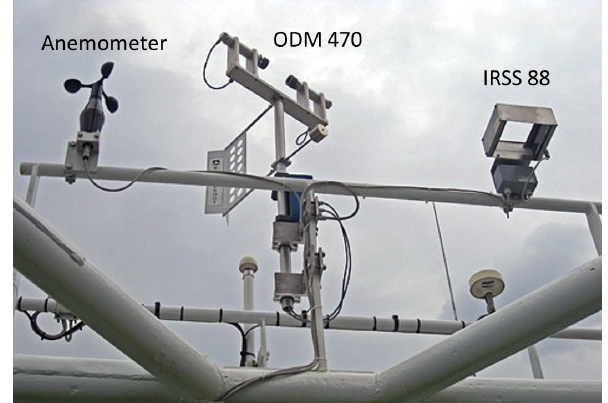
Figure 1. The image displays the automatic ODM470 measure- ment system including a cup anemometer, the optical disdrometer ODM470, and the precipitation detector IRSS88, deployed in the highest main mast at about 43m height onboard RV Polarstern